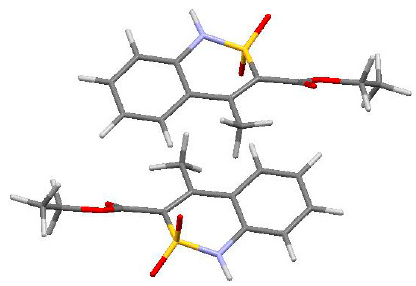
Figure 7. Dimer of the molecules of ester 2 , which is the building unit of the orthorhombic polymorphic form 2O .